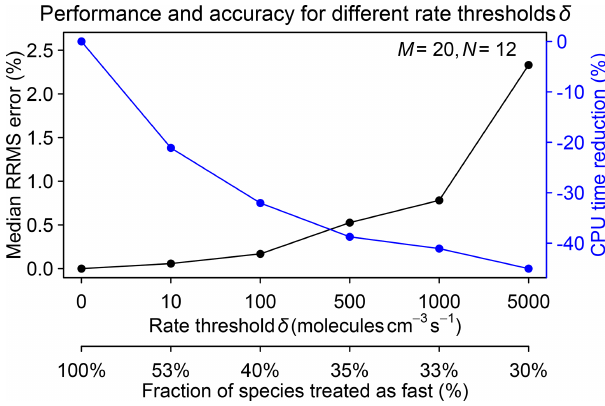
Figure 5. Performance and accuracy of the adaptive chemi- cal mechanism reduction method for different rate thresholds δ (molecules per cubic centimeter per second) to separate fast and slow species. The performance is measured by the reduction in com- puting processor unit (CPU) time for the chemical operator, and the accuracy is measured by the median relative root mean square (RRMS) error for species concentrations relative to a global GEOS- Chem simulation for the troposphere and stratosphere using the full chemical mechanism (228 species treated as fast). The second x axis gives the global fraction of species that need to be treated as fast depending on the value of δ . The number of blocks ( N ) is 12 and the number of chemical regimes ( M ) is